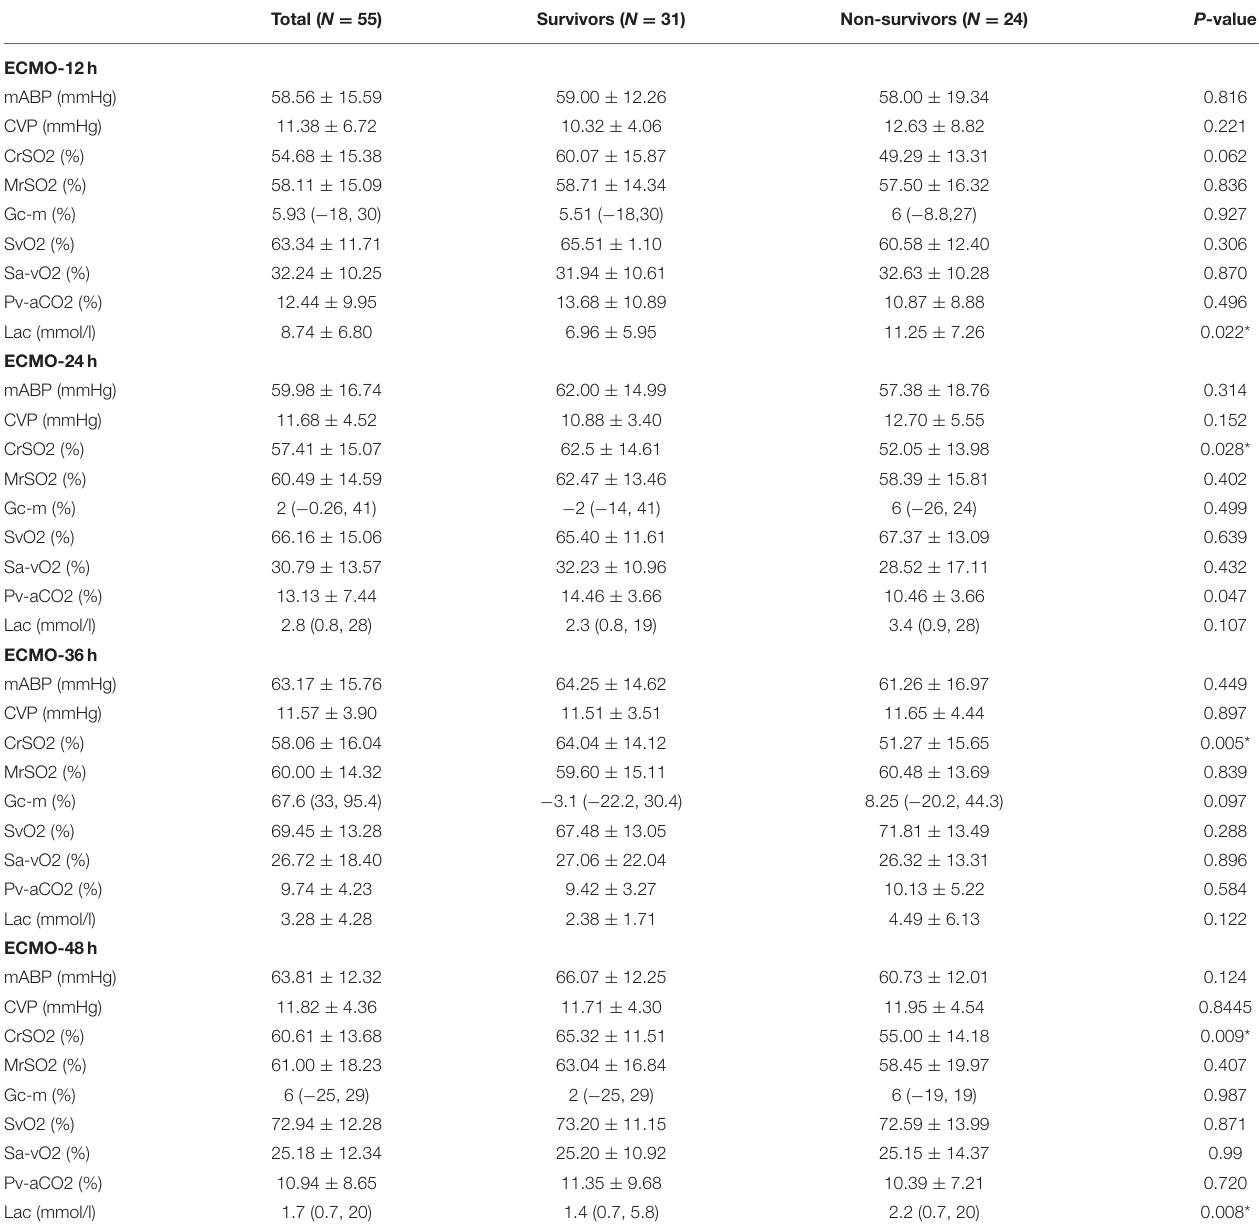
TABLE 3 | Comparison between the monitoring parameters of survivors and non-survivors.